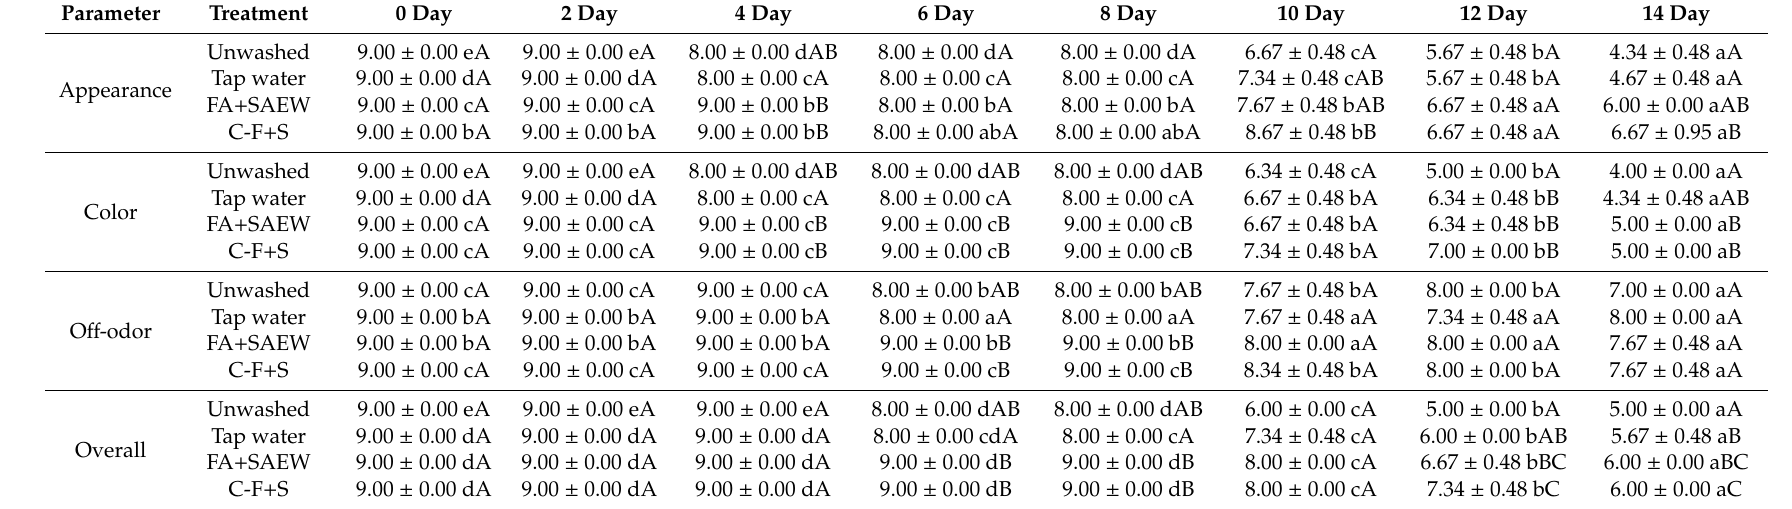
Table 2. Sensory quality changes of fresh mandarin during storage at 4 ◦